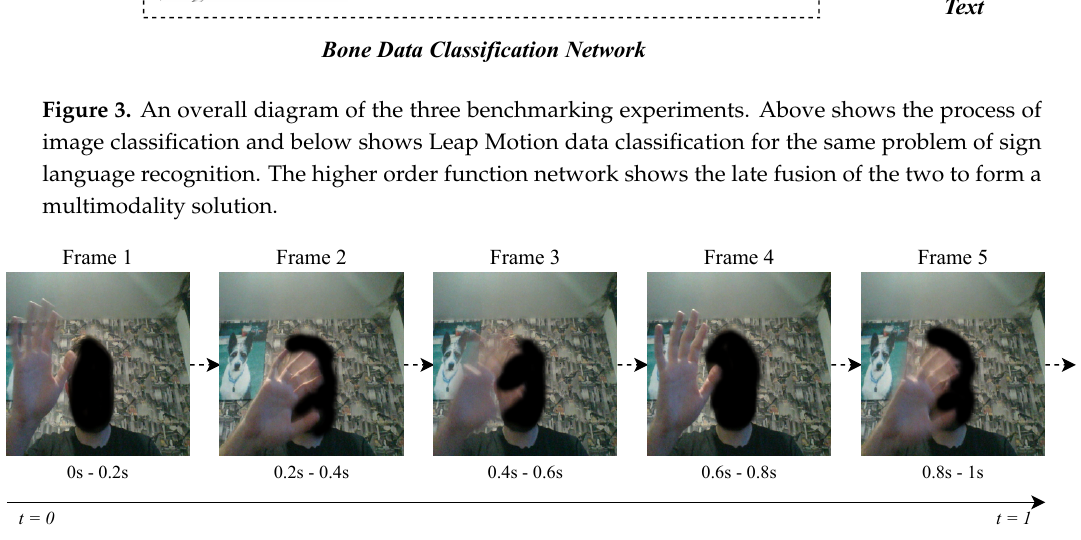
Figure 4. An example of one second of RGB image data collected at a frequency of 0.2 s per frame (5 Hz). Alongside each image that is taken is a numerical vector collected from the Leap Motion